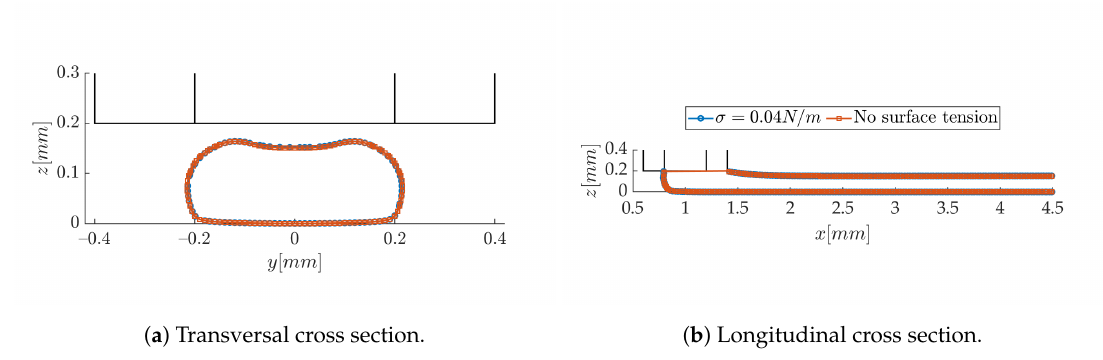
Figure 12. Effect of surface tension of the strand shape ( h / d = 0.5, V / U = 2).